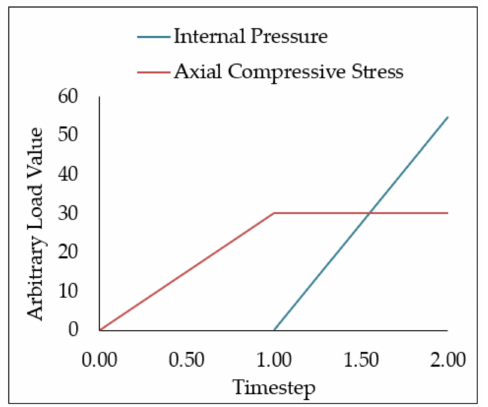
Figure 5. Application of internal pressure and axial compressive stress during FEA.